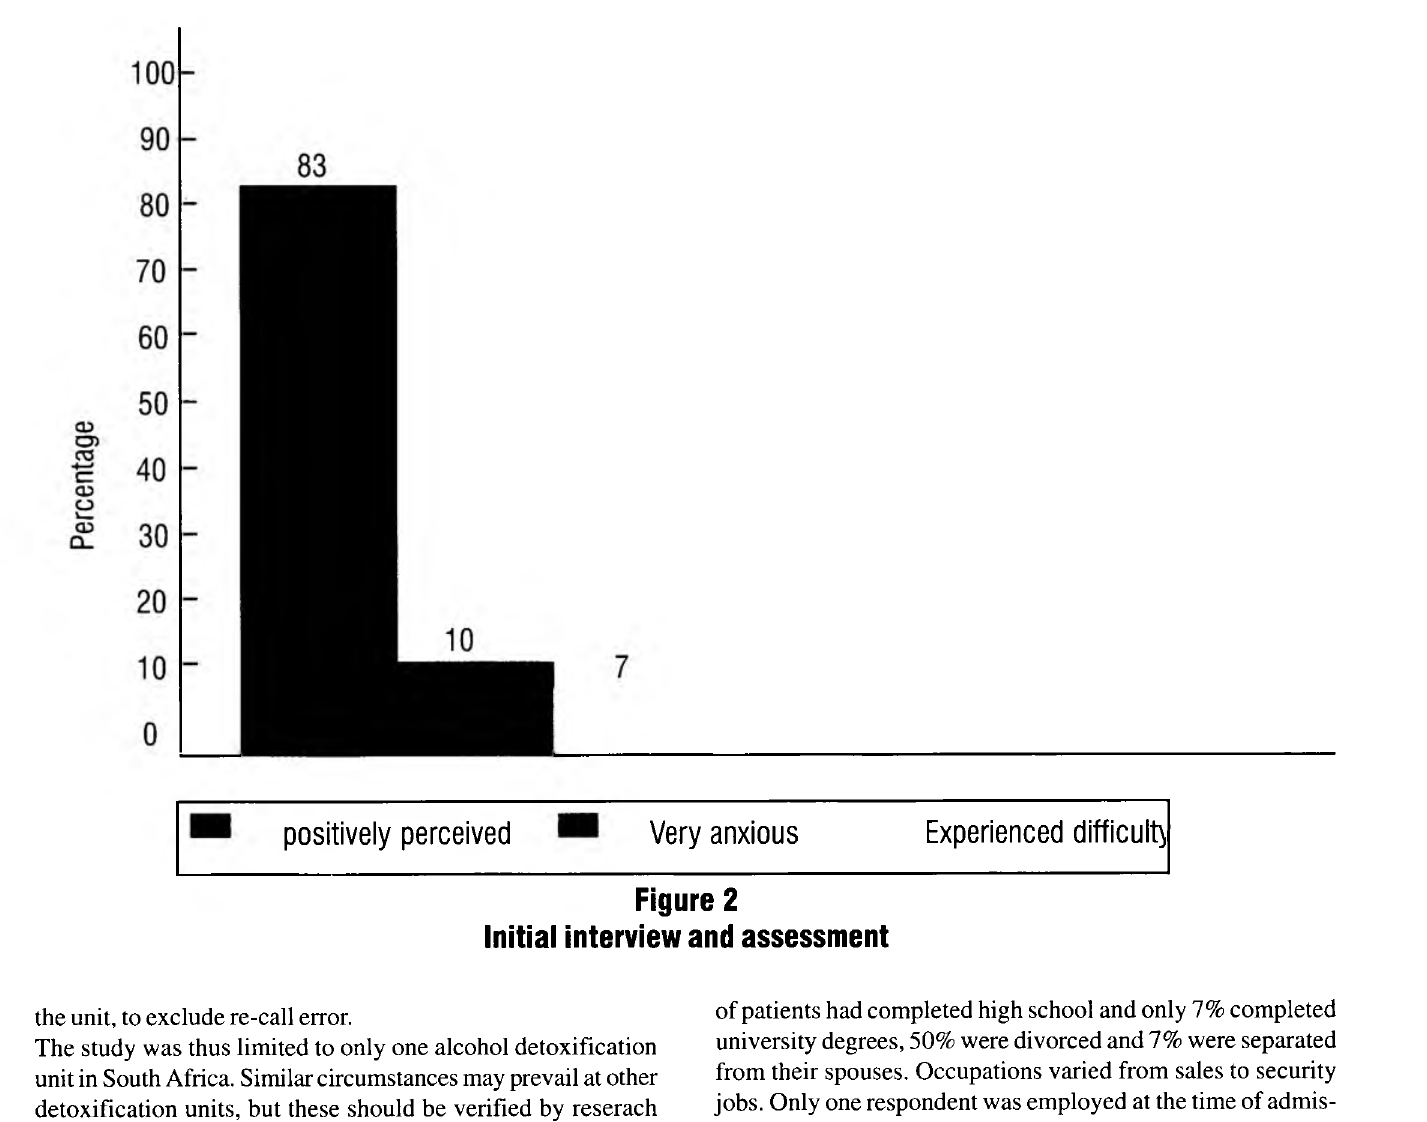
Initial interview and